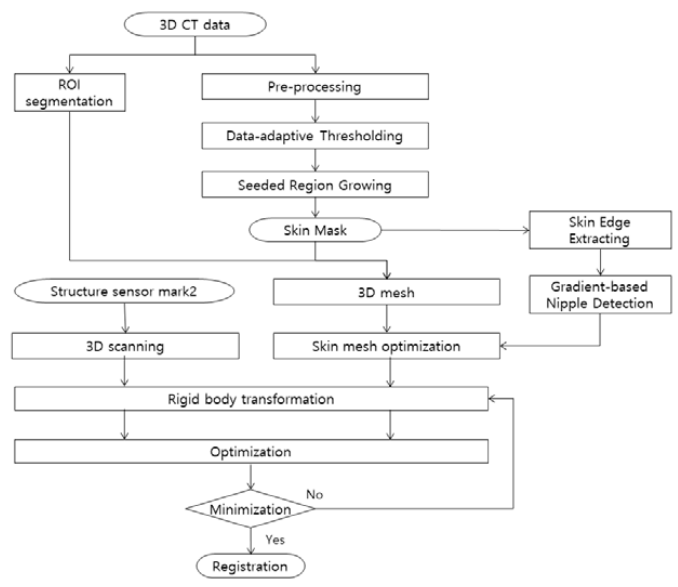
Figure 1. Markerless AR surgical framework.